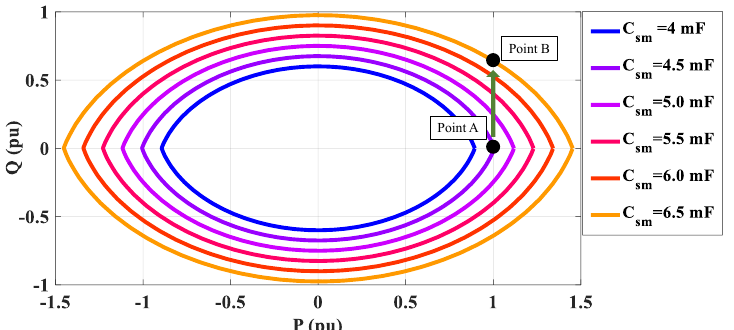
Figure 3. MPQC of MMC under different submodule capacitance